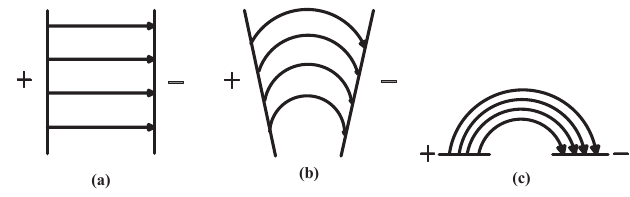
Figure 1. ( a ) is a parallel-plate capacitor; ( a )’s electrodes are gradually opened up turning into ( b ); finally, it becomes ( c ), the fringing electric field